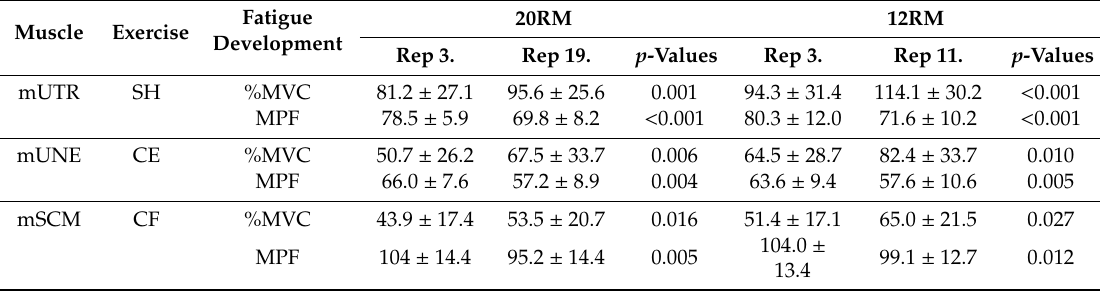
Table 2. The fatigue development of mean muscle activity (%MVE) and mean power frequency (MPF) for the upper trapezius muscle (mUTR), upper neck extensors muscles (mUNE), and sternocleidomastoideus muscles mSCM at intensities of 12 and 20RM. #Values are presented as mean ± SD for the exercises shrugs (SH), cervical extension (CE), and cervical extension (CF) that resulted in the highest activation of each muscle.